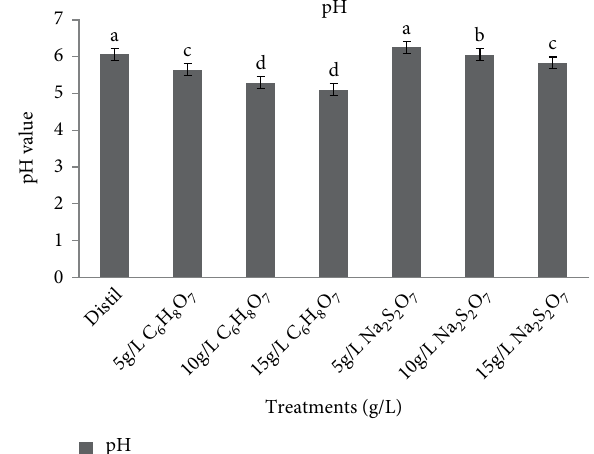
Figure 2: Effect of pretreatment on pH value of Ndou sweet potato flour. Distil = distilled water, C sodium